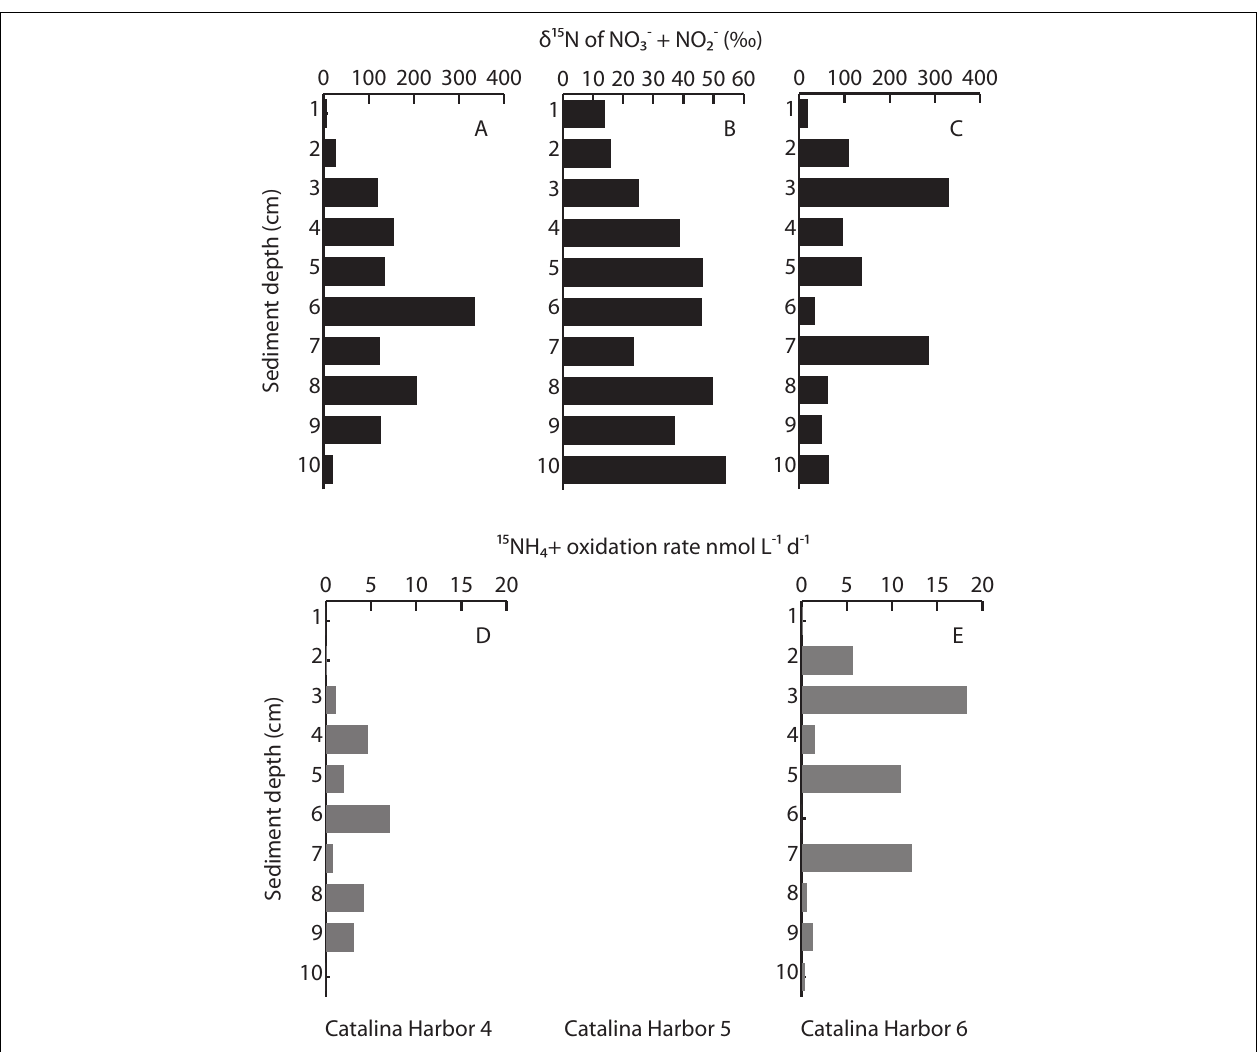
FIGURE 4 | Measured δ 15 N of pore water NO − 3 + NO − 2 following incubation with added 15 NH + 4 label (A–C) , and 15 NH + 4 oxidation rates (D,E) in Catalina Harbor in 2008. Note differences in scales in (A–C) ; oxidation rates were not calculated in Catalina Harbor core 5 owing to the lack of clear isotopic